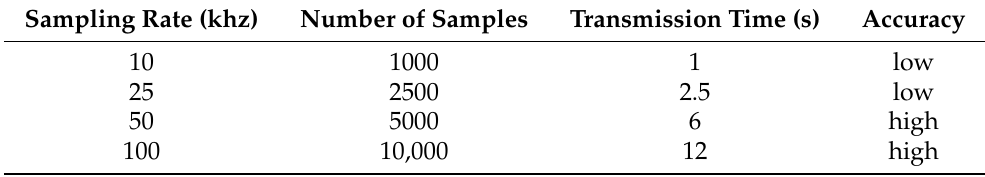
Table 2. Sampling rate and accuracy of appliance